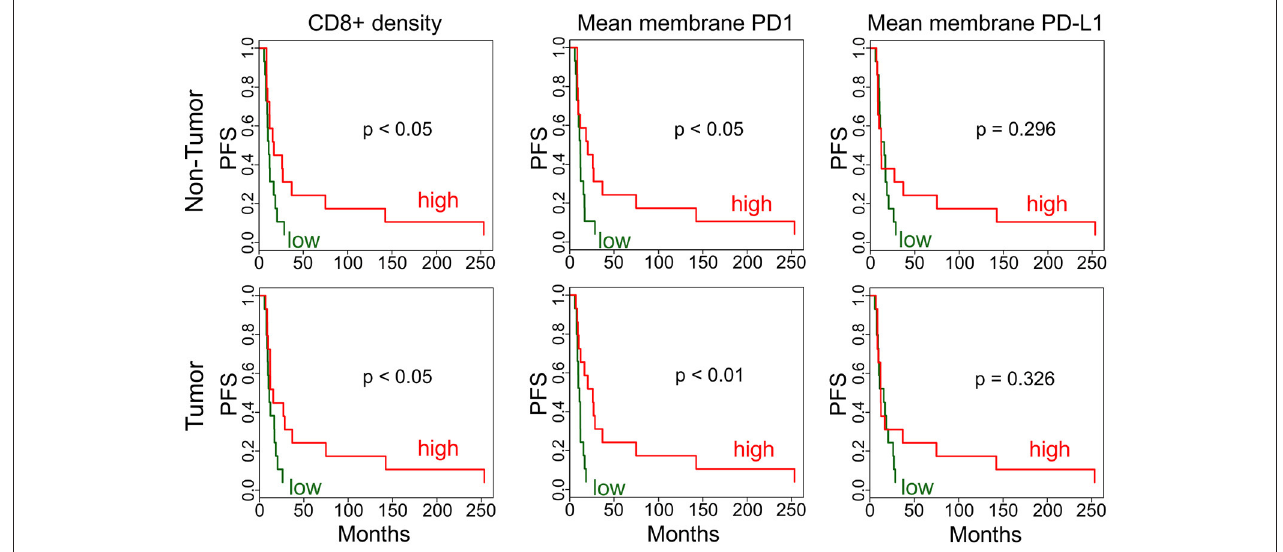
FIGURE 3 | Immunohistochemistry analysis of tumors and adjacent non-tumors. Kaplan-Meier plots are applied to analyze PFS associations in non-tumor and tumor for CD8 + phenotype density (counts/mm 2 ) and mean membrane PD1 and PD-L1 expression. High (red) is the above median density/expression group, low (green) is below